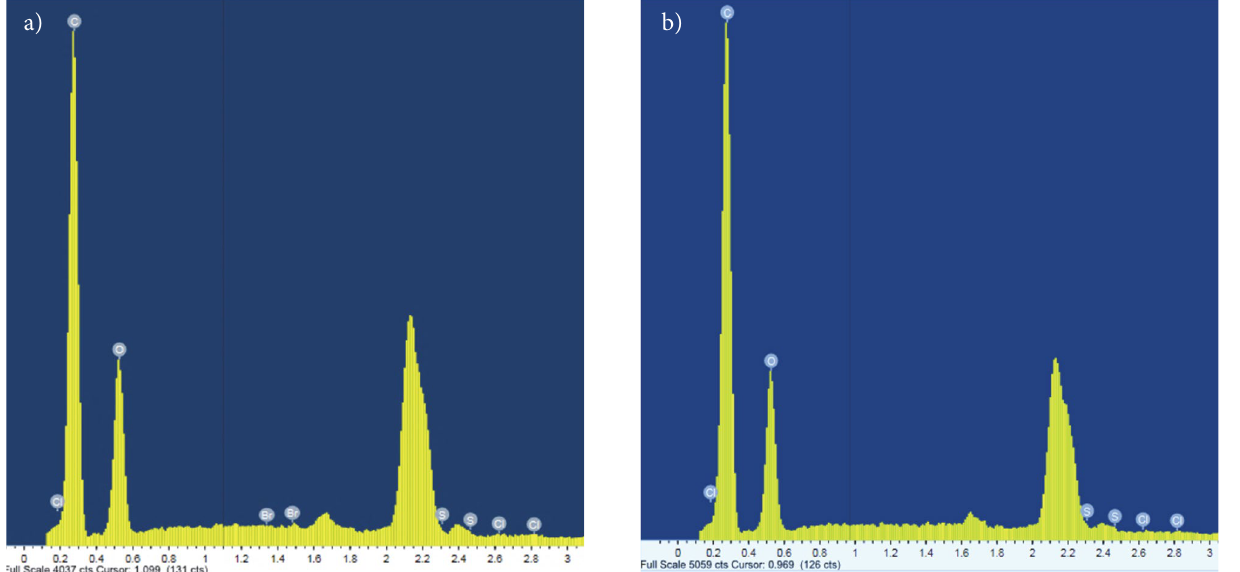
Fig. 4. EDX spectra of AAPS (a) prior to adsorption and (b) following adsorption.